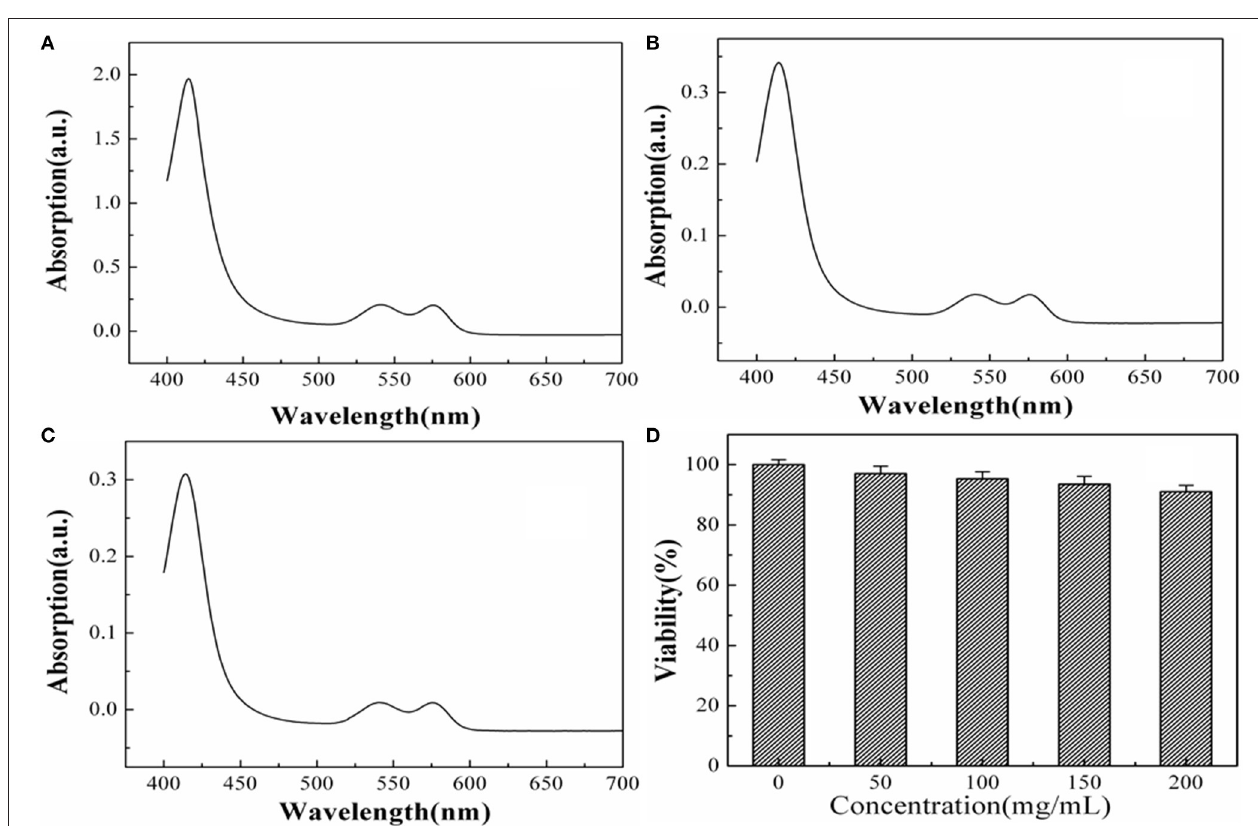
FIGURE 5 | The absorption curves of positive groups (a) , experimental groups (b) , and negative groups (c) . The cell viability of BaF 2 :Nd NPs on HeLa cells at the concentration of 50–200 µ g mL − 1 with an incubation time of 48h (d) .